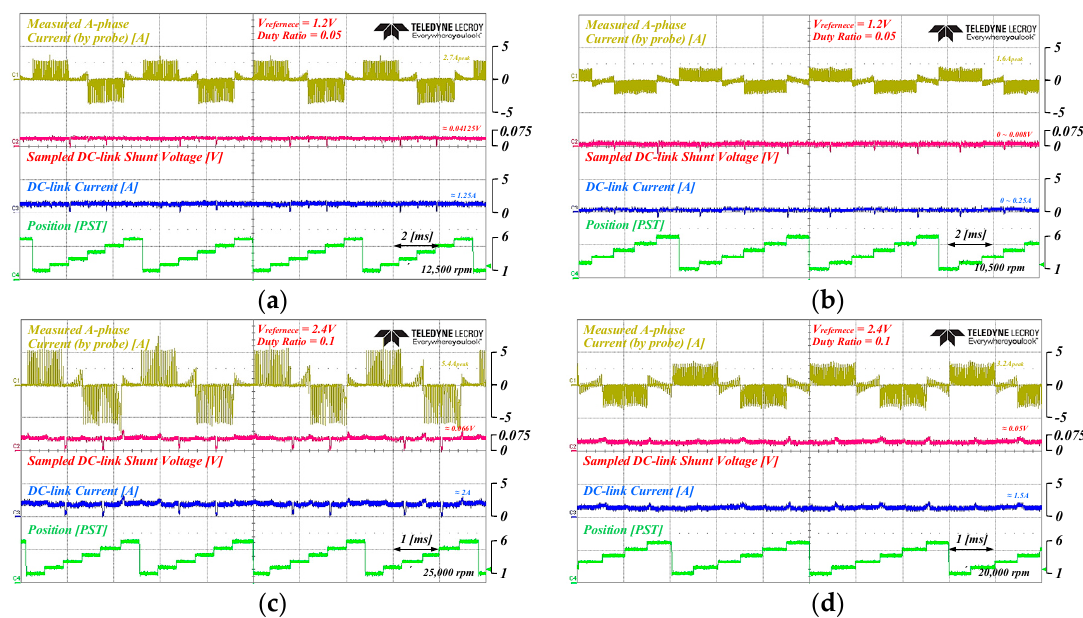
Figure 10. Experimental results on DC-link current measurement using a single shunt: ( a ) H-PWM- L-ON method (0.05 duty ratio); ( b ) H-PWM-L-PWM method (0.05 duty ratio); ( c ) H-PWM-L-ON method (0.1 duty ratio); and ( d ) H-PWM-L-PWM method (0.1 duty ratio).